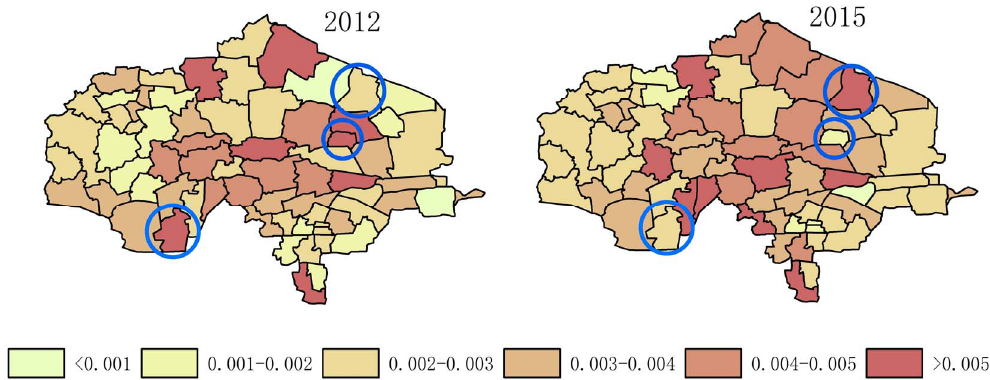
Figure 12. The difference in the proportion of centenarians in the aging population between different